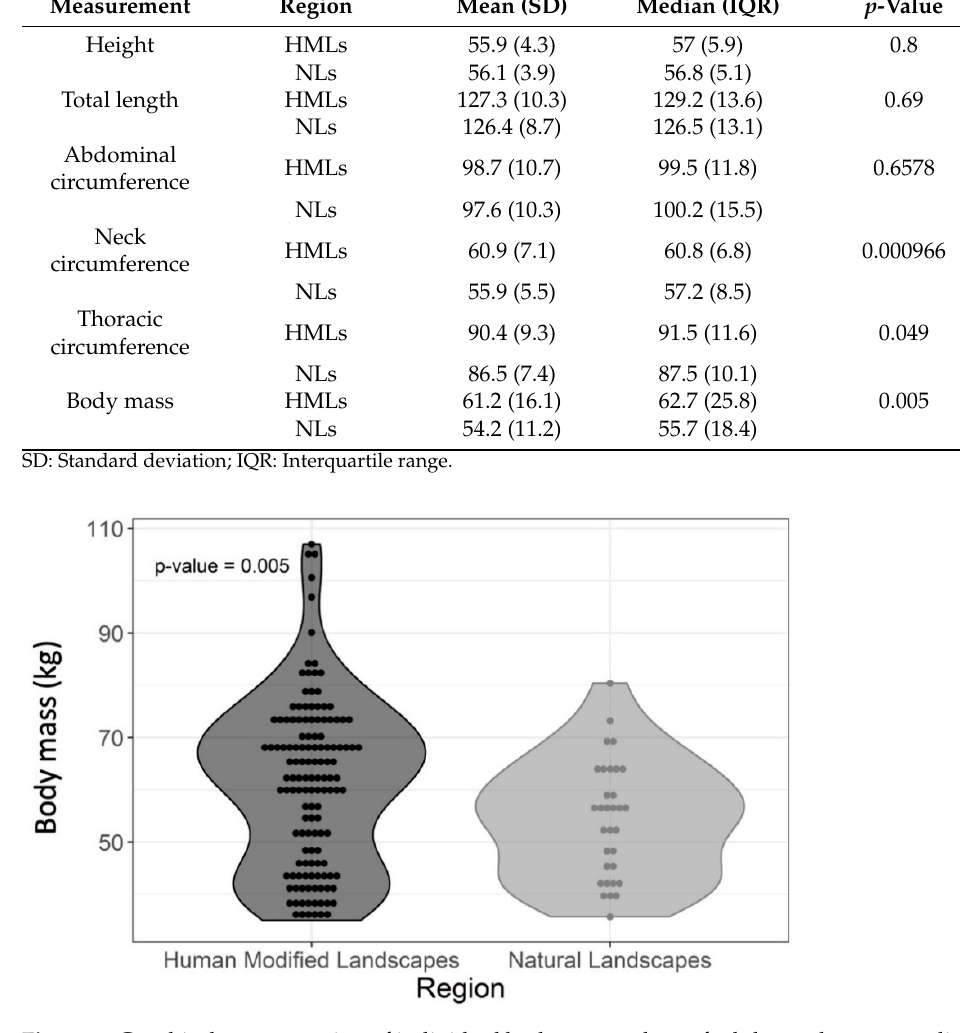
Figure 2. Graphical representation of individual body mass values of adult capybaras according to the study region (landscape type).